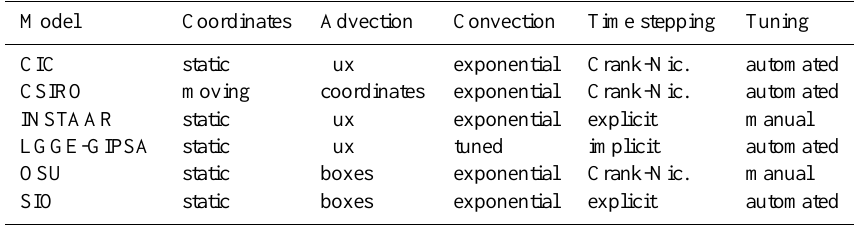
Table 3. Overview of firn air transport models. See text for explanation. Model Coordinates Advection Convection Time stepping Tuning CIC static flux exponential Crank-Nic. automated CSIRO moving coordinates exponential Crank-Nic. automated INSTAAR static flux exponential explicit manual LGGE-GIPSA static flux tuned implicit automated OSU static boxes exponential Crank-Nic. manual SIO static boxes exponential explicit